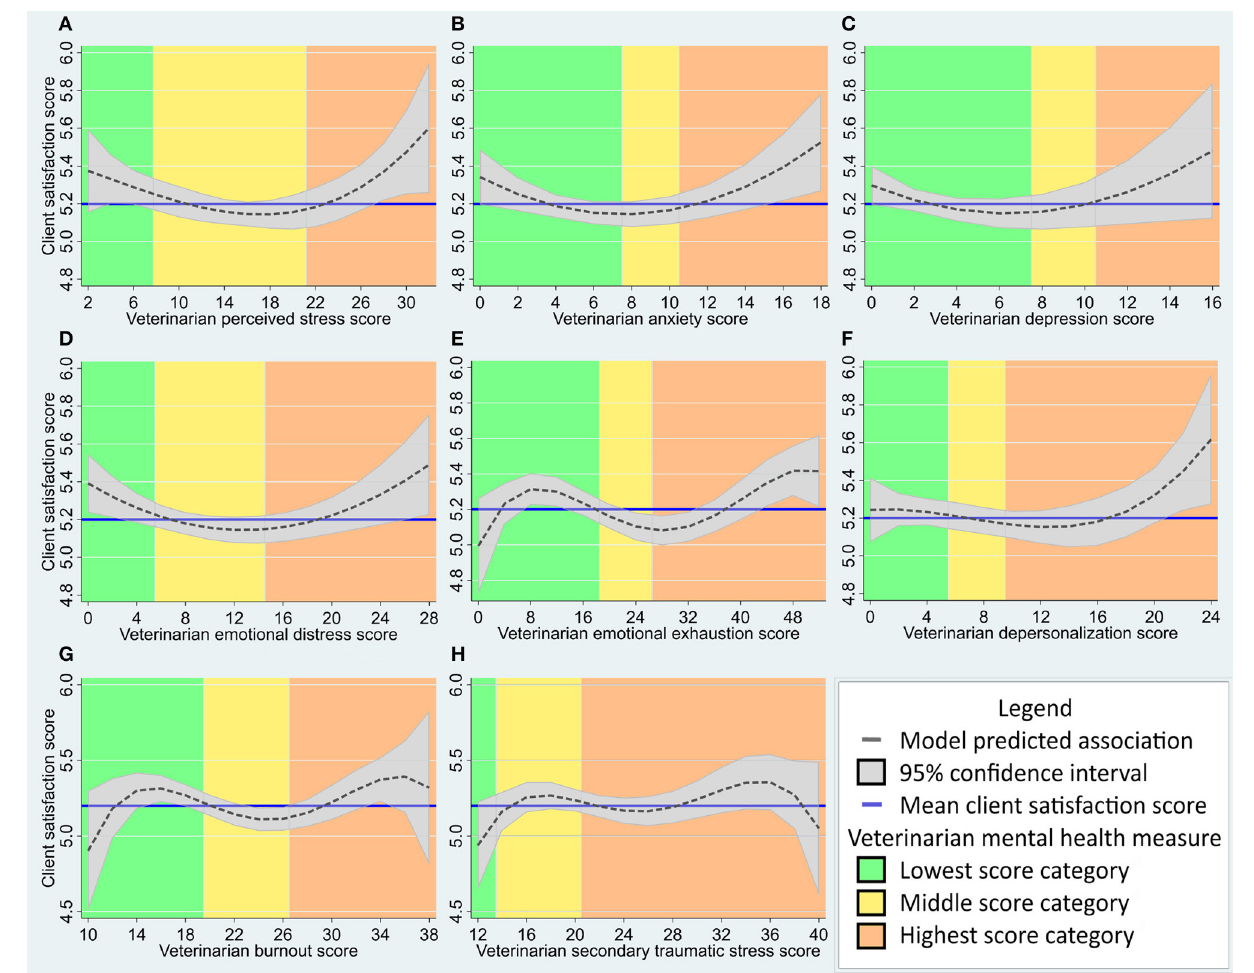
FIGURE 3 | (A–H) Predicted association between veterinary client satisfaction (as measured by the Client Satisfaction Questionnaire, n varies from 800 to 995 as described in results) and veterinarian mental health measures ( n = 60) in a multivariable, multilevel linear regression model. Veterinarian mental health measures include: (A) Perceived Stress Scale score; (B) Hospital Anxiety and Depression Scale (HADS) anxiety subscale score; (C) HADS depression subscale score; (D) HADS emotional distress score; (E) Maslach Burnout Inventory—Human Services Survey (MBI-HSS) Emotional Exhaustion subscale score; (F) MBI-HSS Depersonalization subscale score; (G) Professional Quality of Life (ProQOL) Burnout subscale score; and (H) ProQOL Secondary Traumatic Stress subscale score. Mean client satisfaction score and mental health measure categories (as described in methods) are provided for reference. The client satisfaction score axis has been standardized to include the interquartile score range for this population (4.9–5.9) and the X-axis has been adjusted for the range of scores seen in this